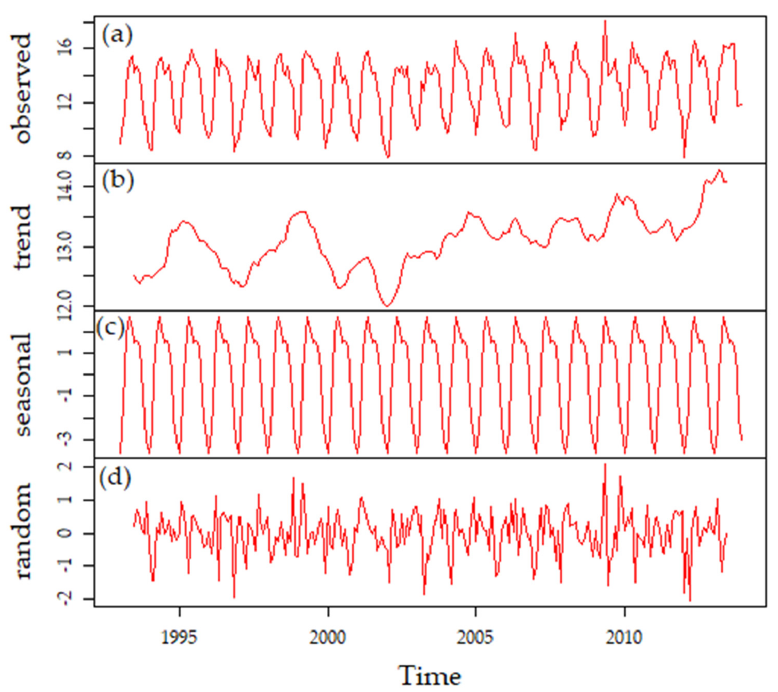
Figure 3. Decomposition of additive time series of monthly air temperature values recorded at the SMN weather station 21,052 (1993 to 2013). The observed data is represented in the upper panel ( a ), while the next panels show the additive components [( b ) long-term trend, ( c ) seasonal, and ( d ) random components]. There were no statistically significant trends of increasing or decreasing annual rain- fall, nor when analysed separately in the dry and rainy seasons. Rainfall monthly values decreased from 1993 to 1999 (Figure 4). From 1999 on, there were fluctuations between rainier and drier periods until 2013, the end of the record. The monthly rainfall had a negative linear correlation with the SOI ( r = − 0.16, p < 0.05) and a positive linear correlation with the AMO index ( r = 0.24, p < 0.05).